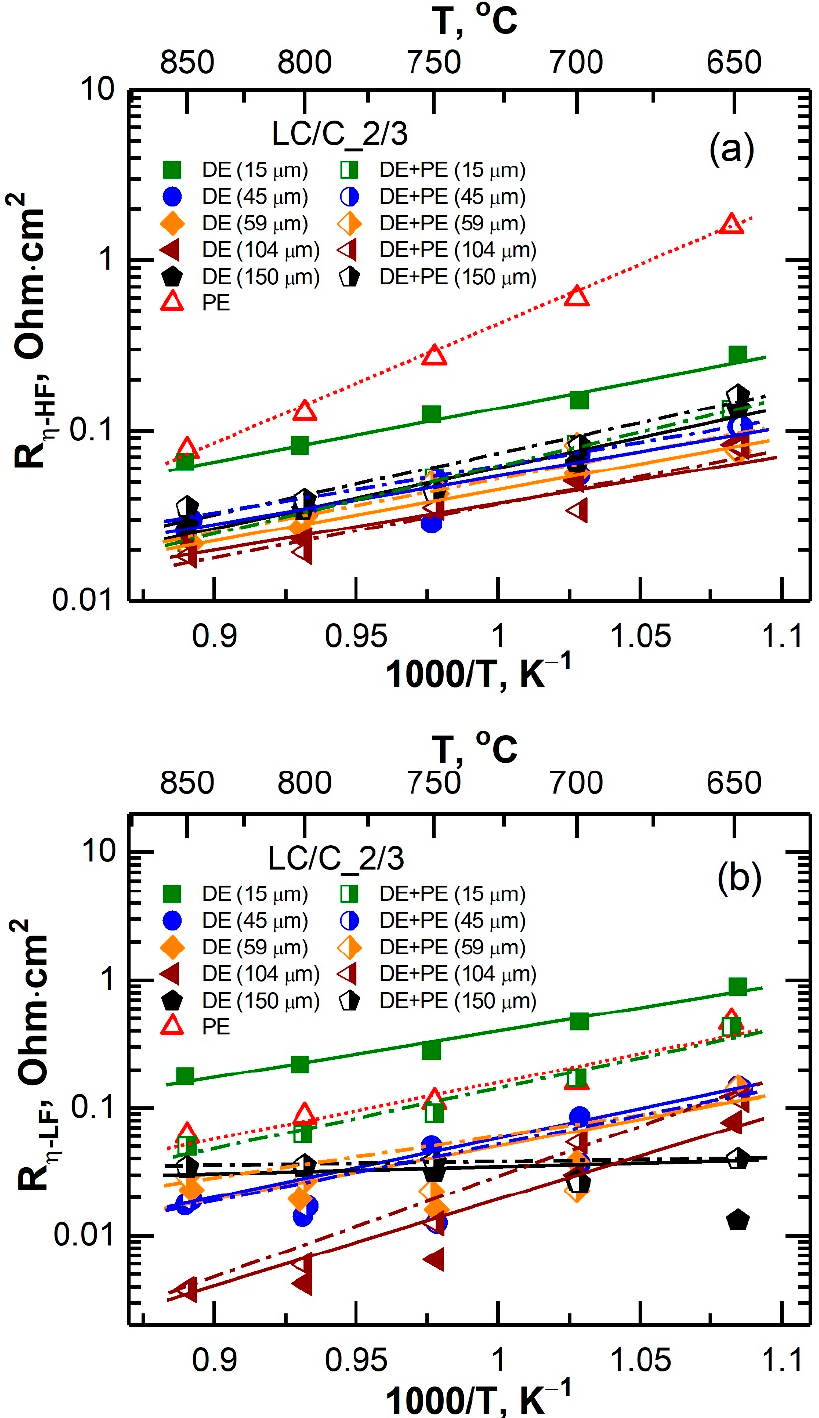
Figure 5. Temperature dependence of the ( a ) high-frequency (HF) and ( b ) low-frequency (LF) contribution of the polarization resistance of the investigated electrodes.